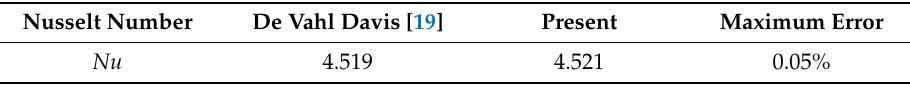
Table 2. Comparison of numerical results with previous work ( Ra = 10 5 ).